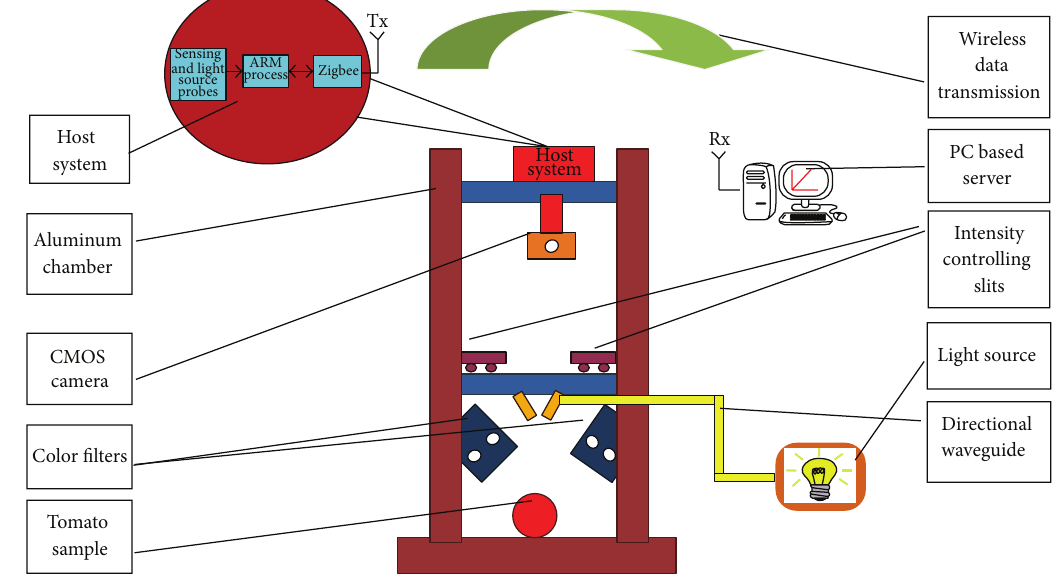
Figure 2: Experimental setup for tomato image acquisition.